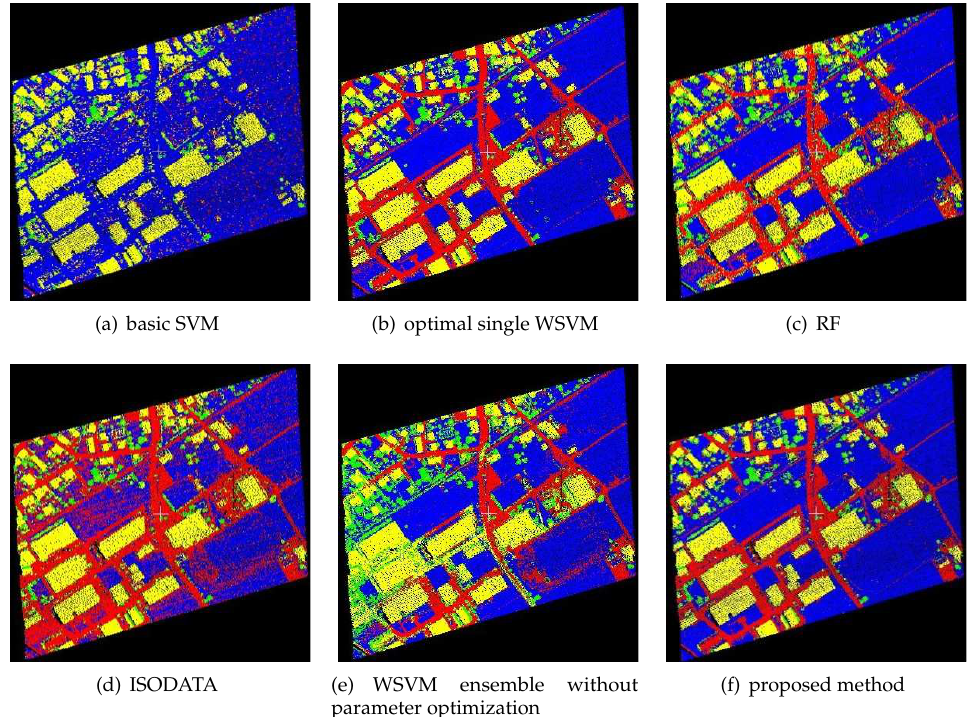
Figure 5. Classification results of Study Area